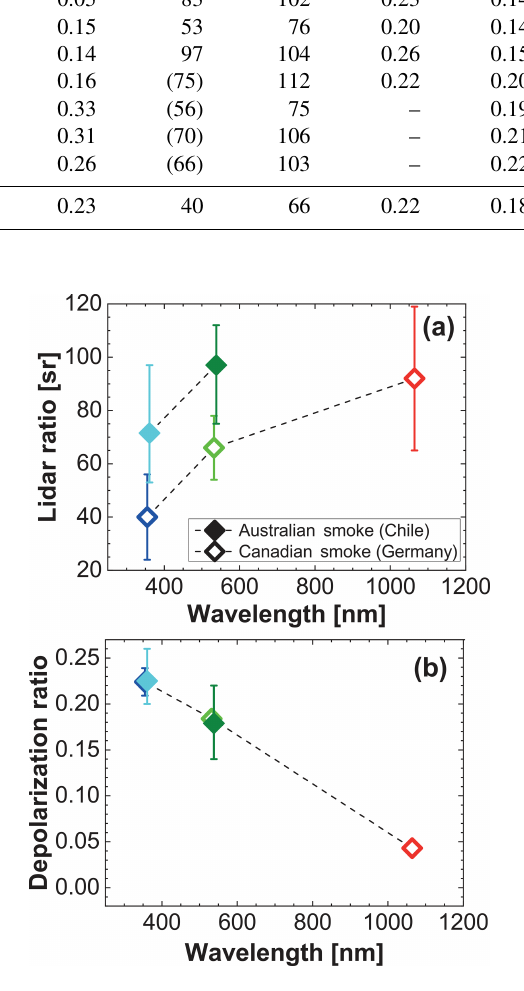
Figure 4. Comparison of the spectral dependence of (a) the lidar ra- tio and (b) the particle linear depolarization ratio of aged Canadian and Australian smoke as measured in the stratosphere over Leipzig, Germany, on 22 August 2017 (open symbols) and over Punta Are- nas, Chile, in January 2020 (closed symbols). In the case of the Australian smoke, mean values of the seven cases in Table 1 are shown, and the vertical bar indicates the full range of found values. In the case of the Canadian smoke values (measurement case from 22 August 2017), vertical bars show the retrieval